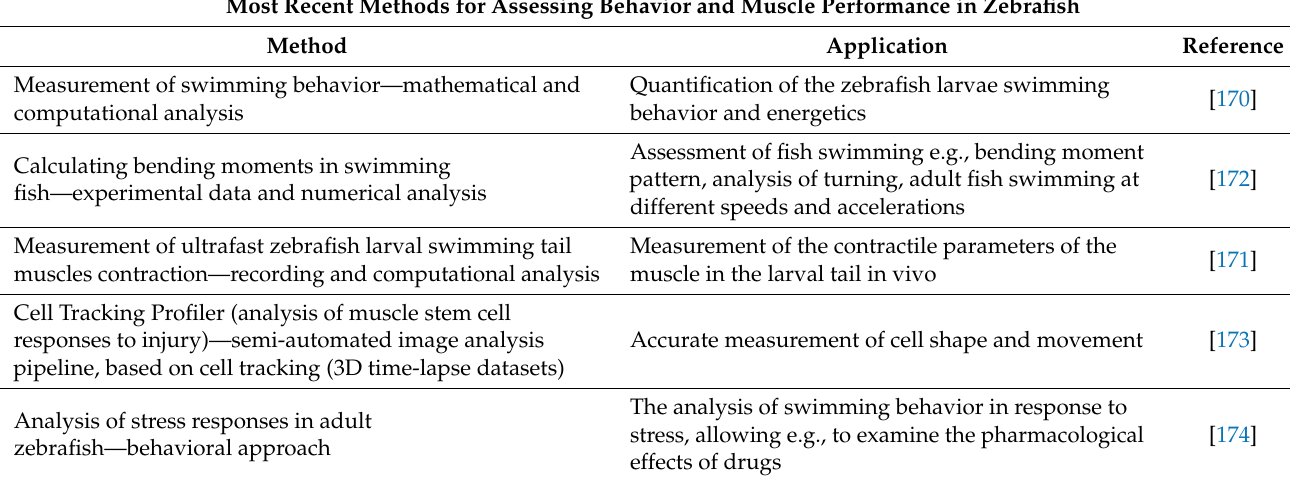
Table 2. List of current methods and techniques for assessing behavior and muscle performance in zebrafish. Most Recent Methods for Assessing Behavior and Muscle Performance in Zebrafish Method Measurement of swimming behavior—mathematical and computational analysis behavior and energetics Assessment of fish swimming e.g., bending moment Calculating bending moments in swimming pattern, analysis of turning, adult fish swimming at fish—experimental data and numerical analysis different speeds and accelerations Measurement of the contractile parameters of the muscle in the larval tail in vivo Accurate measurement of cell shape and